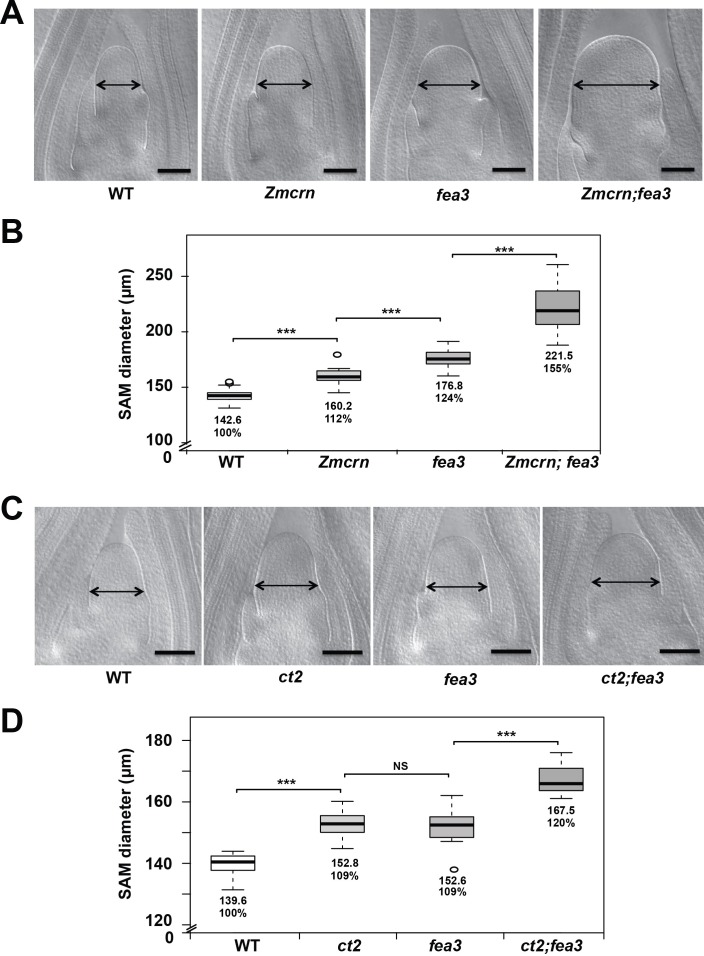
ZmCRN and CT2 function in a different pathway to FEA3.(A) Cleared SAMs from wild-type (WT), Zmcrn, fea3, and double-mutant plants. SAMs from Zmcrn and fea3 plants were wider than those in wild type (double-headed arrows), and Zmcrn;fea3 double mutants were wider compared to the single mutants. SAM diameter was quantified in (B). (C) Cleared SAMs from wild-type (WT), ct2, fea3, and double-mutant plants. SAMs from ct2 and fea3 plants were wider than those in wild type (double-headed arrows), and the double mutants were wider compared to the single mutants. SAM diameter was quantified in (D). Scale bars: 100 μm in A. n = 28 plants for each genotype, except of Zmcrn;fea3 double (n = 15). Data in B and D are shown by box plots. The mean values as well as the relative % to the WT control are listed. ‘***': P value < 0.0001, two-tailed, two-sample t test.10.7554/eLife.35673.020Figure 5—figure supplement 1—source data 1.SAM size of Zmcrn;fea3 in a segregating population.